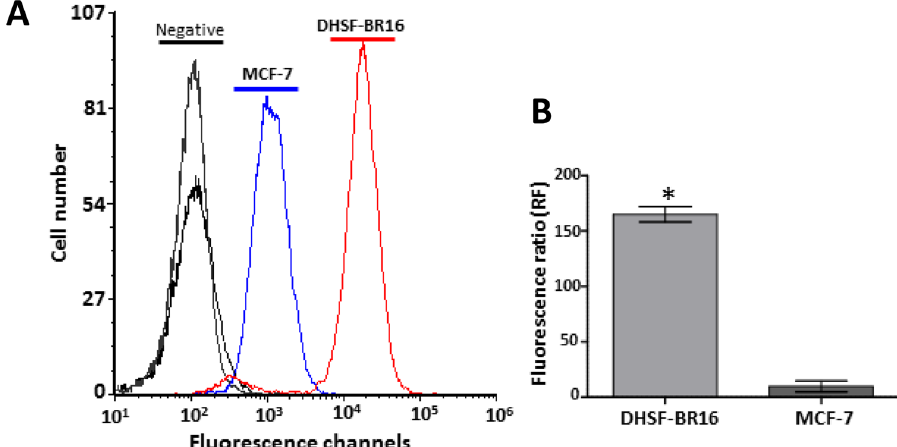
Figure 2. ROS generation in DHSF-BR16 and MCF-7 cells. In the presence of ROS, DCFH-DA is converted to a fluorescent compound. ( A ) Fluorescence curves are representative of three experiments. ( B ) Fluorescence Ratio between mean fluorescence intensity (MFI) of DCFH-DA-treated cells and negative samples. The results are presented as mean ± SE of three replicates. * p <